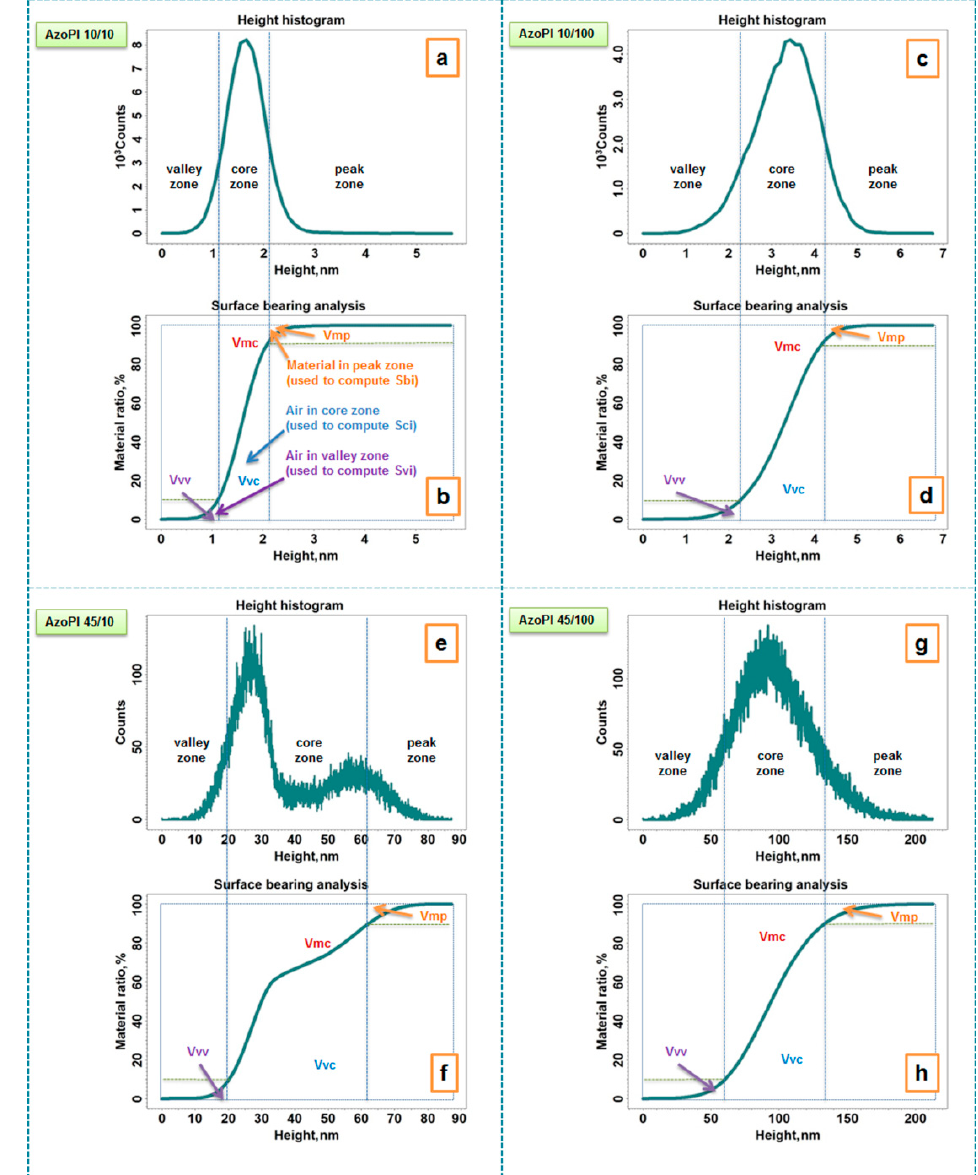
Figure 4. Height histograms and surface bearing area ratio curves corresponding to height AFM images for azo-polyimide irradiated using different laser energy density/number of pulses of irradiation: 10 mJ/cm 2 /10 pulses ( a , b ), 10 mJ/cm 2 /100 pulses ( c , d ), 45 mJ/cm 2 /10 pulses ( e , f ), 45 mJ/cm 2 /100 pulses ( g , h ).